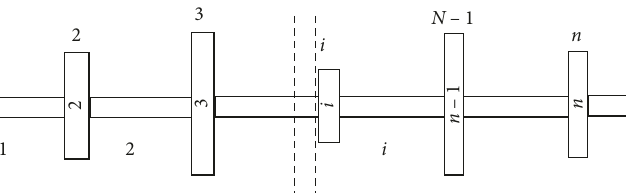
Figure 2: Shaft torsional vibration